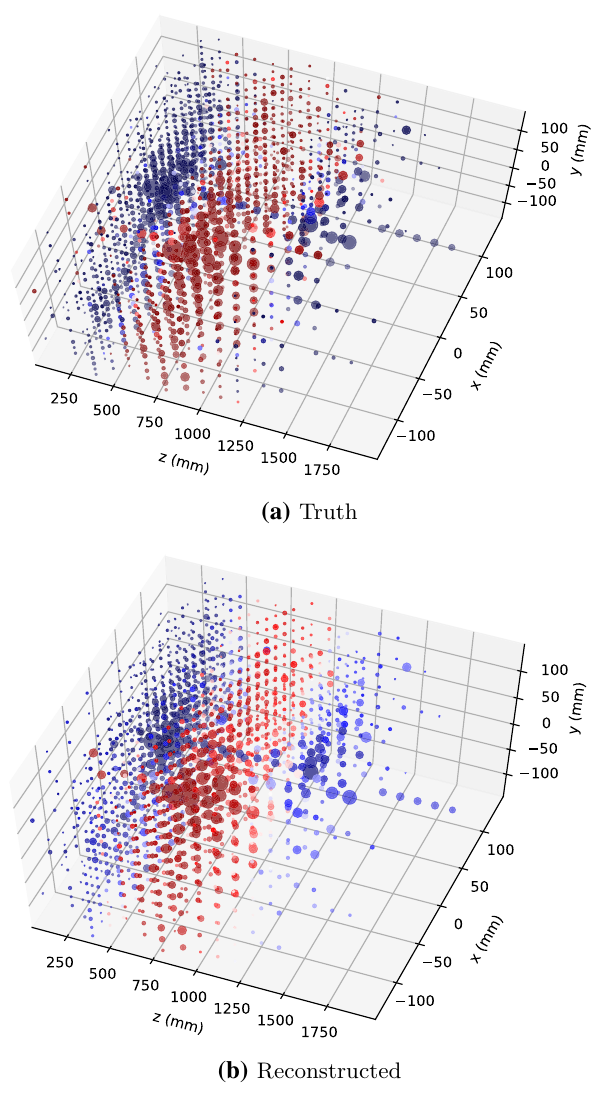
Fig. 3 Comparisonoftrueenergyfractionsandenergyfractionsrecon- structed by the GravNet model for two charged pions with an energy of approximately 50GeV showering in different parts of the calorime- ter. Colours indicate the fraction belonging to each of the showers. The size of the markers scales with the square root of the energy deposit in each sensor